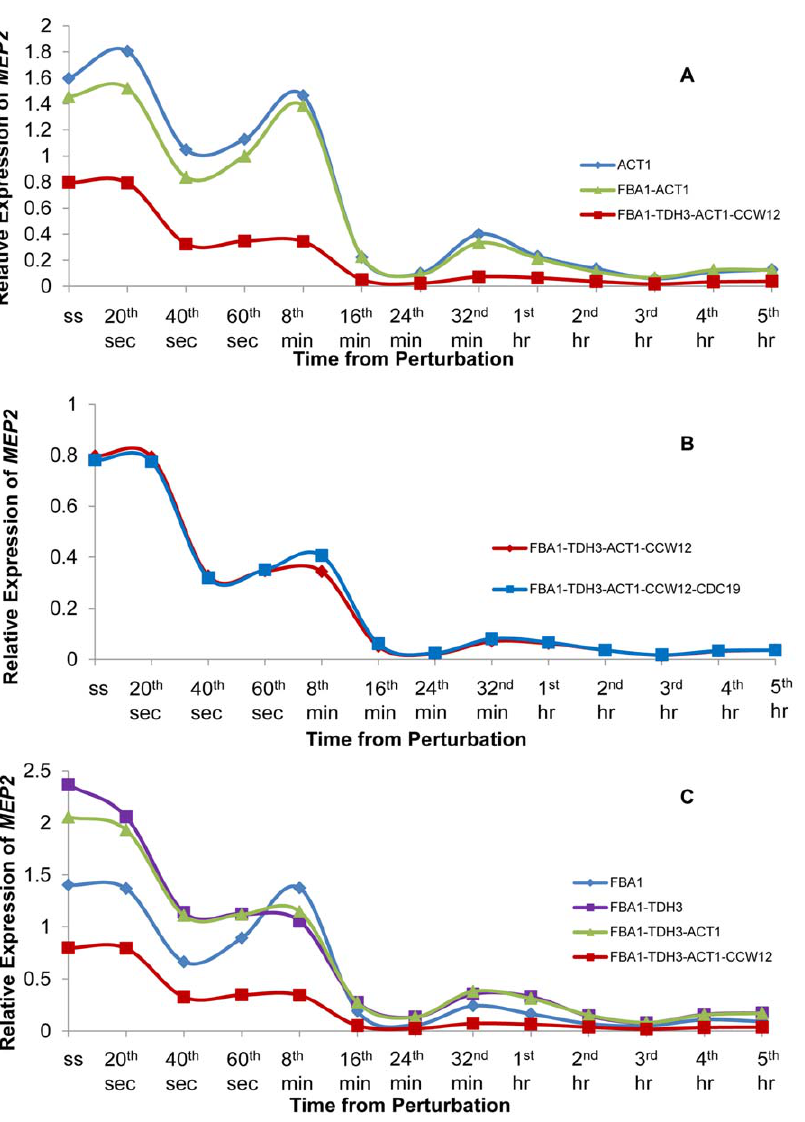
Figure 4. Expression profile of MEP2 as a response to the relaxation from ammonium limitation. This figure represents the expression profile for MEP2 using different combinations of reference genes, which were selected from the candidate pool. The expression profiles were calculated using ACT1 ; a commonly selected reference gene, using FBA1 and ACT1 ; the two most stable genes identified from P-0 by geNorm, and using FBA1 , TDH3 , ACT1 and CCW12 ; the final set of most stable genes (A). The contribution of increasing the number of genes in the final reference set to the expression profile of MEP2 was investigated by adding CDC19 to the reference gene set (B). The effect of reducing number of genes in the final reference gene set on the expression profile of MEP2 was investigated. The number of reference genes included in the set was reduced by one each time starting from the least stable gene in the set (C). For each individual profile, the reference genes, which were used in the determination of MEP2 expression, were indicated by different colours in the